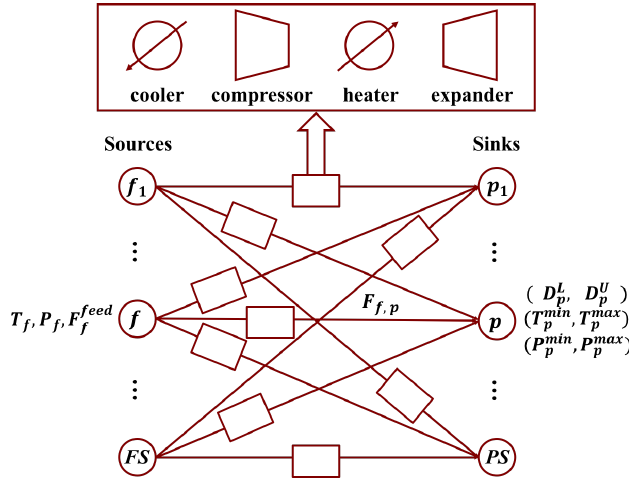
Figure 1. A classic superstructure for the fuel gas